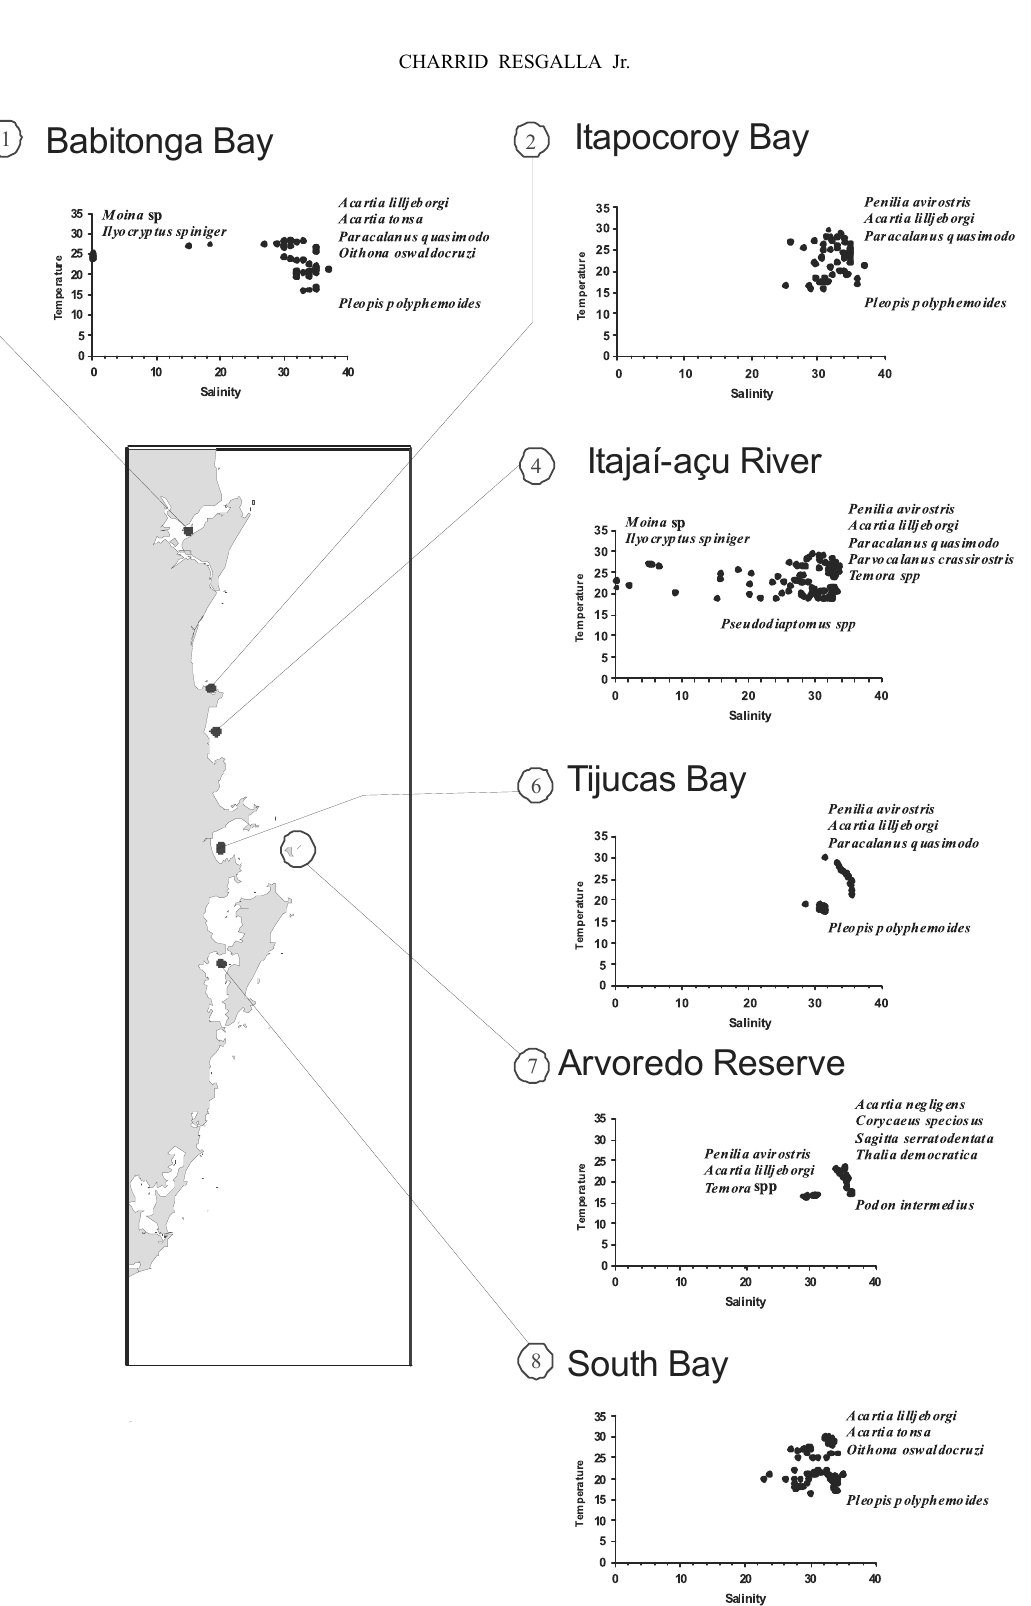
Fig. 2 – TS diagrams and main species of zooplankton organisms occurring on the Santa Catarina coast. The numbers refer to the environments described in Figure 1 and Table